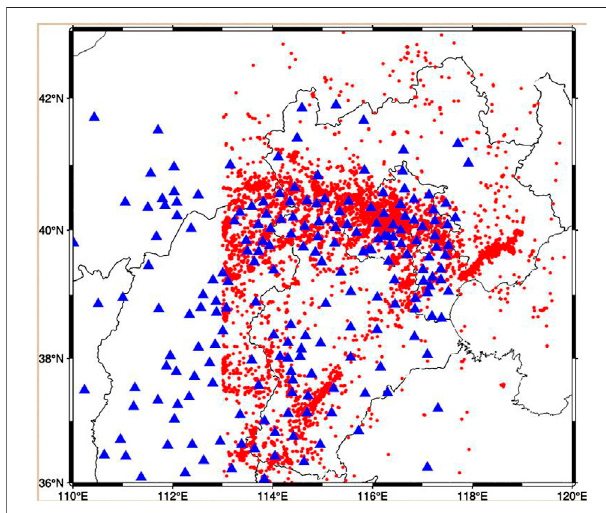
FIGURE 2 | Distribution of seismic station (blue triangle) and earthquake epicenter (red circle) used in this study.